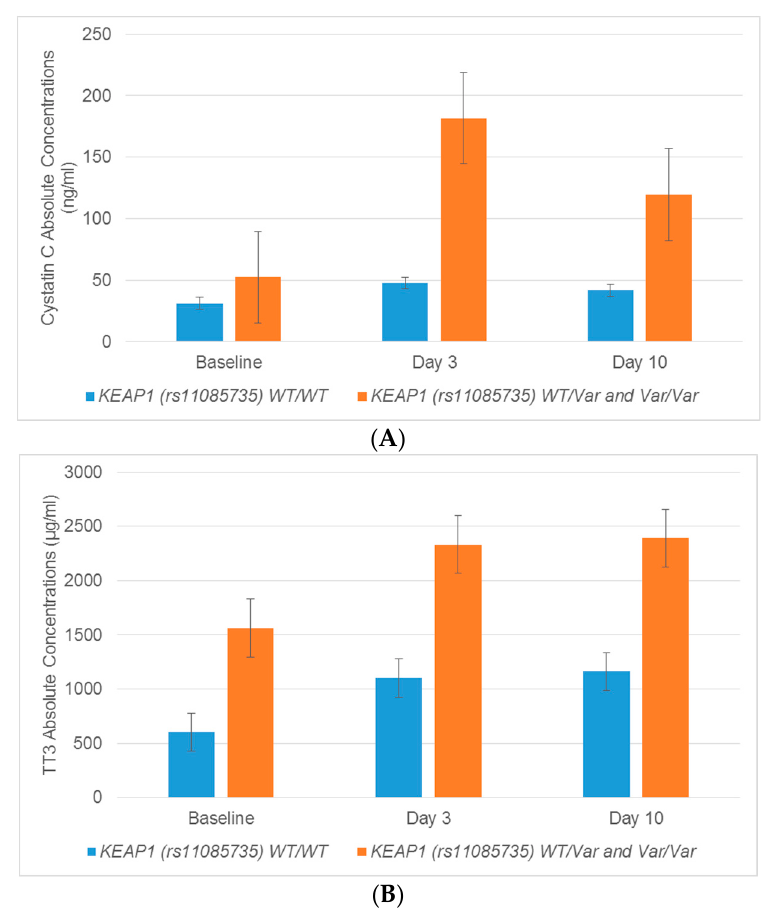
Figure 4. Variant alleles in KEAP1 (rs11085735) are correlated with increased concentrations of TFF3 and cystatin C. ( A ) Absolute concentrations of cystatin C showed a statistically significant increase on Day 3 ( p = 0.01) and Day 10 ( p = 0.03) in patients expressing the variant allele of KEAP1 . ( B ) Absolute concentrations of TFF3 were increased at baseline ( p = 0.01), Day 3 ( p = 0.03) and Day 10 ( p = 0.03) in patients who carried at least one variant copy of KEAP1 . Error bars represent standard